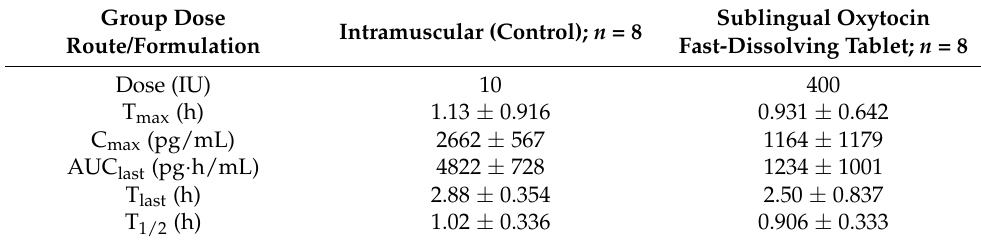
Table 4. Comparison of mean oxytocin pharmacokinetic parameters for intramuscular versus sublin- gual